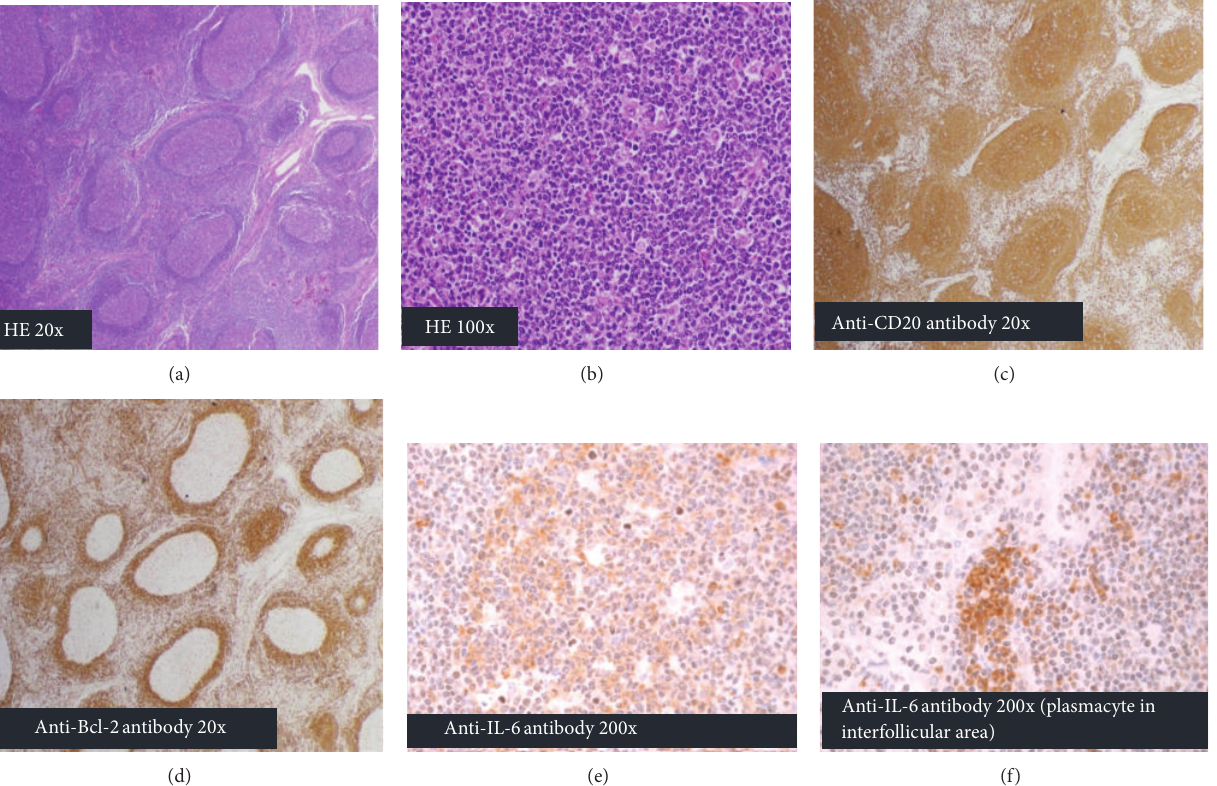
Figure 2: Histopathological and histoimmunochemical features of lymph node biopsy. Lymph node biopsy showed follicular hyperplasia and germinal center proliferation with narrowed mantle-zone ((a): HE stain, × 20). No dysplasia was seen in germinal center and hemophagocytic cells are scattered in this area ((b): HE stain, × 100). The lymphocytes forming in the germinal center were CD20 positive (c), BCL-2 negative (d), and IL-6 positive (e). Plasmacytes in interfollicular area were also IL-6 positive